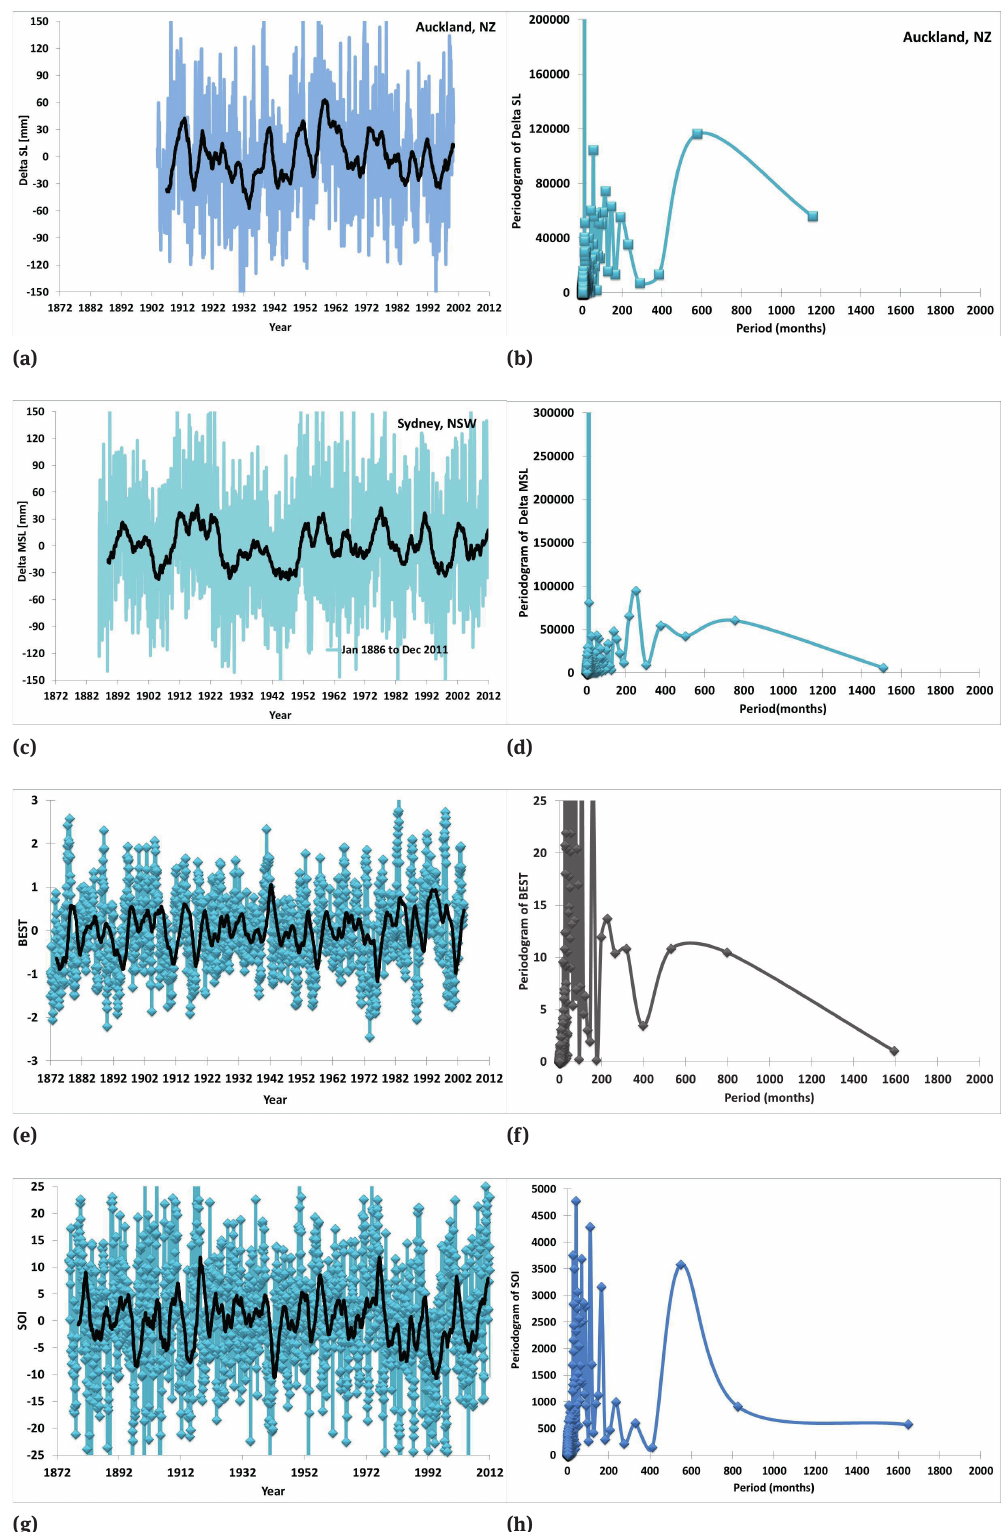
Fig. 1. Monthly average sea level oscillations about the linear trend in the Sydney, NSW and Auckland, NZ tide gauges and periodograms from their time series analysis. Monthly values of BEST and SOI indices and their periodograms. 36 months moving averages superim-